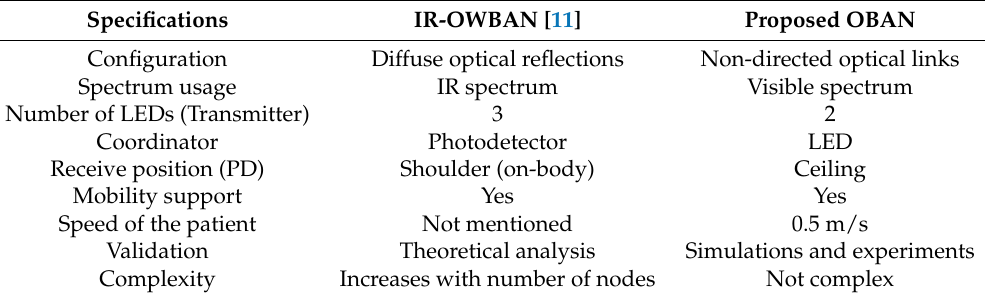
Table 4. Comparison of proposed system and existing